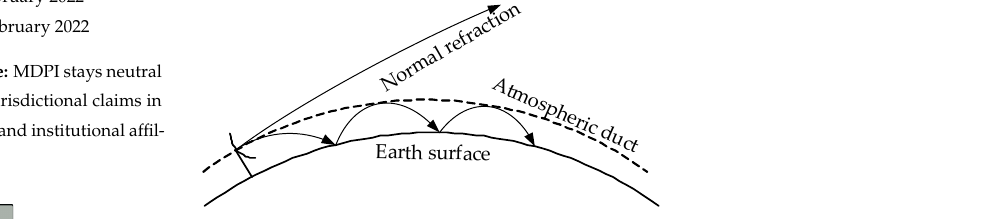
Figure 1. Radio wave propagation trajectory under normal refraction and atmospheric duct.